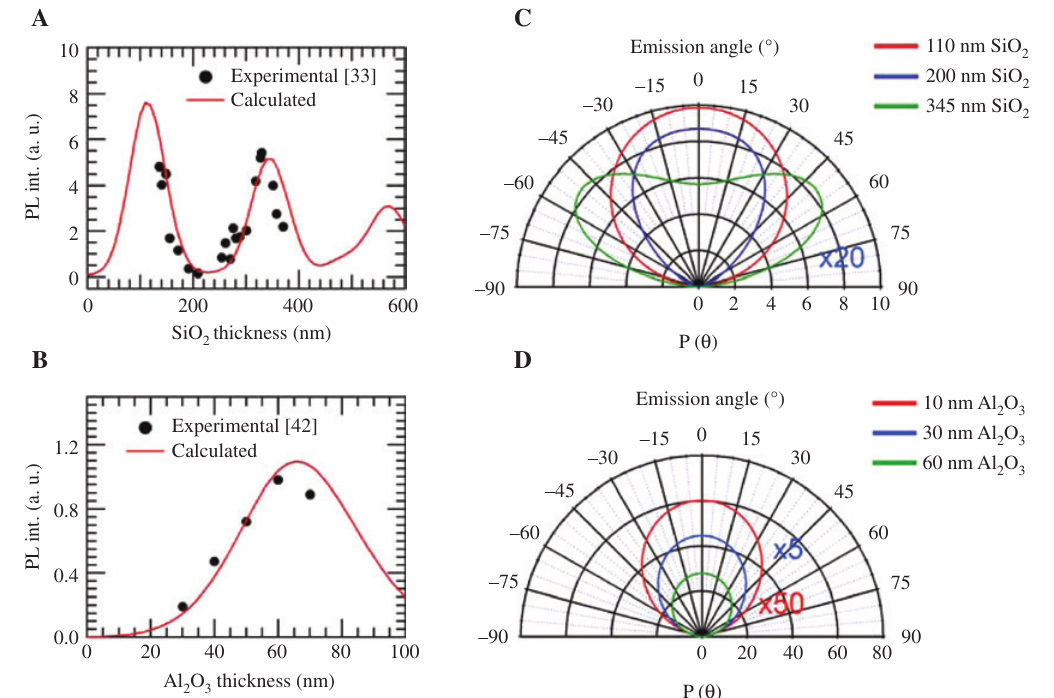
deposited onto Si/SiO (A) and Al/Al O (B) 2 2 2 3 layers of 110, 200, and 345 nm of 2